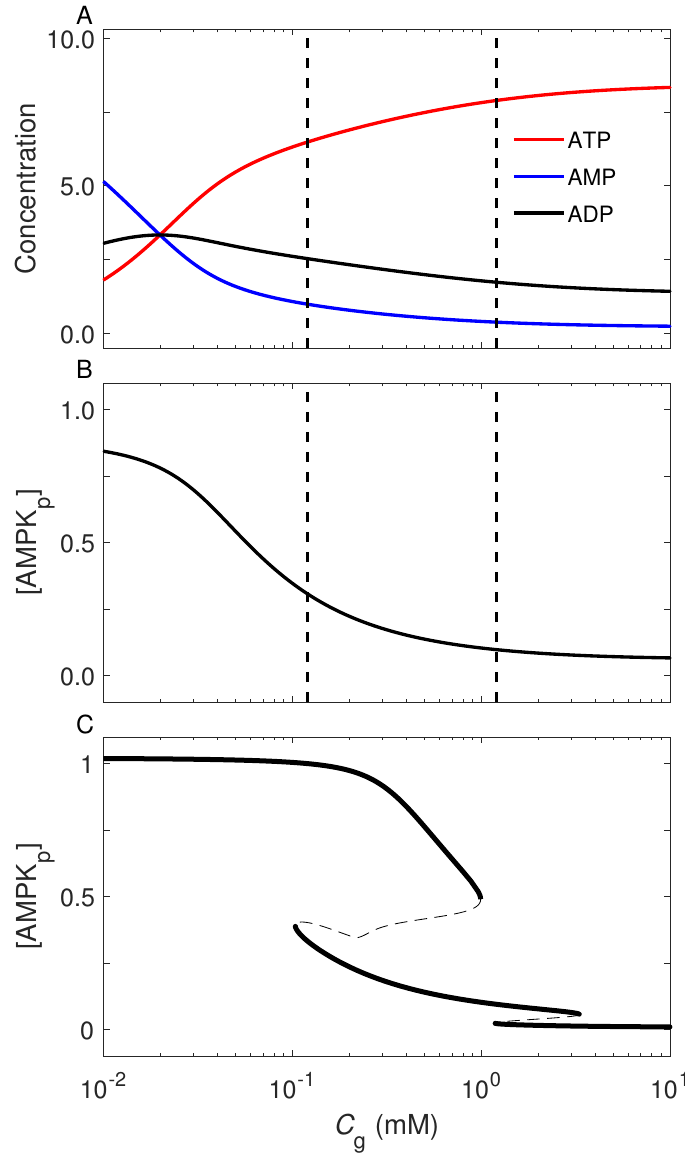
Figure 2. 2 Figure 2. AMPK acts as a sensor of cellular energy status. ( A , B ) Steady-state levels of ATP, ADP, and AMP ( A ) and activated AMPK ( B ) vs. the concentration of extracellular glucose, C g . Here, only modules in Figure 1a,b were considered; the total level of AMPK was set to 1, while the concentrations of Akt p , p53 p and mTOR* were set to 1, 0.7, and 1, respectively, irrespective of C g . Two dashed lines mark the lower bifurcation points in panel ( C ). ( C ) Bifurcation diagram for [AMPK p ] as a function of C g in the full model. The stable and unstable steady states are denoted by solid and dashed lines,